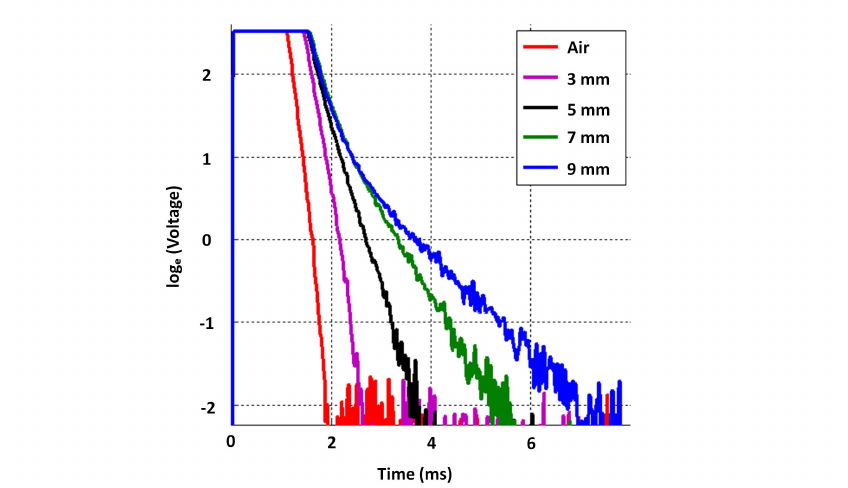
Figure 18. Sensitivity to low thickness at reduced excitation amplitude (3 V) at 14 mm lift-off; sharp rising edges of signals are not discriminable in the ms time scale and appear to be overlapping.